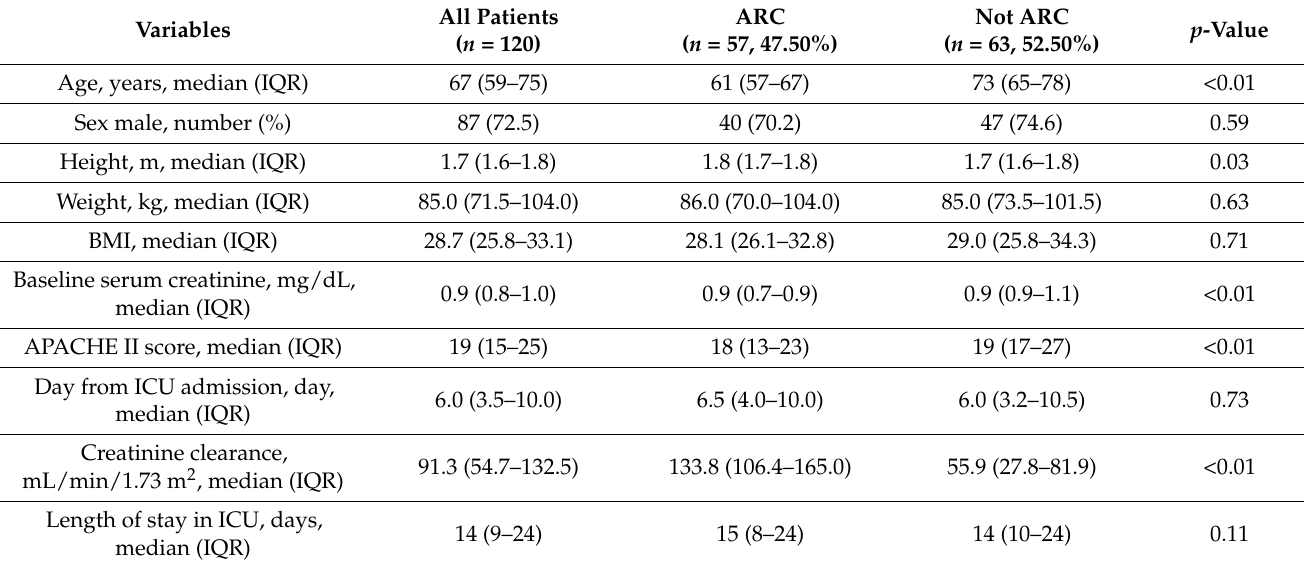
Figure 1. Consort diagram. ESKD, end-stage kidney disease; CrCl, creatinine clearance; KRT, kidney replacement therapy; SCr, serum creatinine; ICU, intensive care unit. Table 1. Patient characteristics and clinical outcomes (per patient).